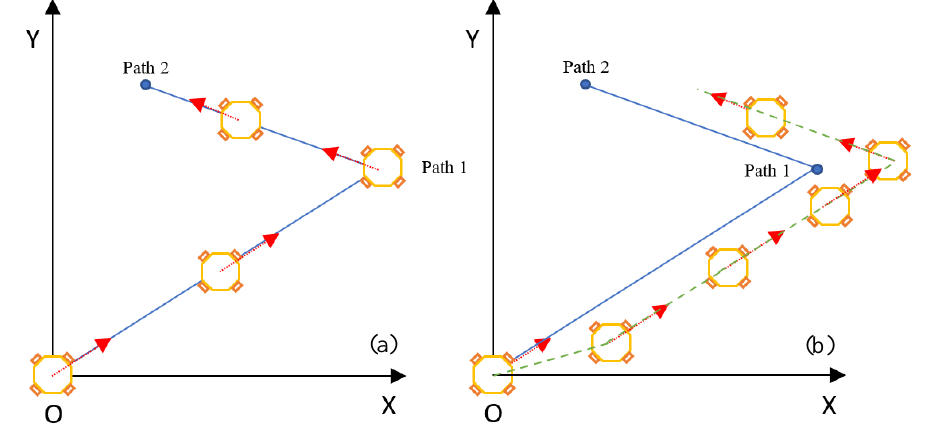
Figure 5. (a) Illustration of Ideal Robot Movement (b) Error in Robot Movement.